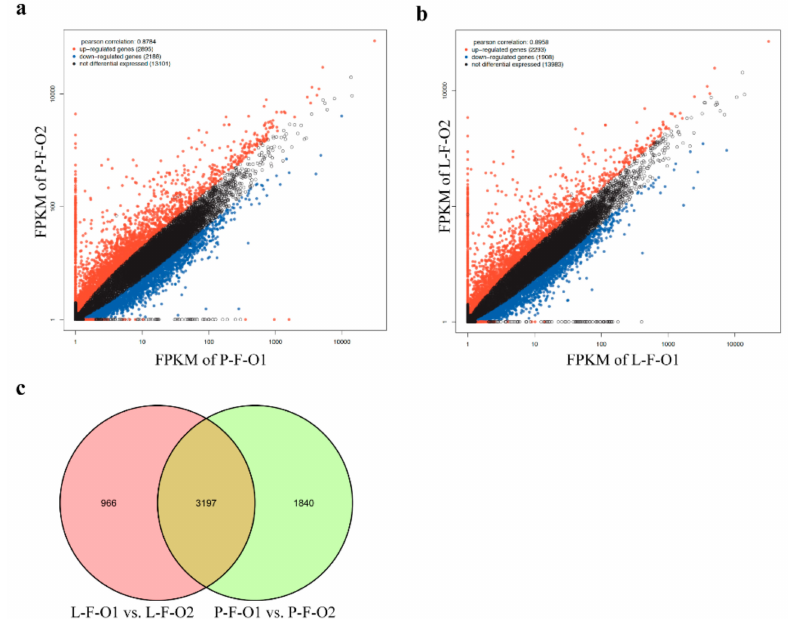
Figure 2. Two comparisons of di ff erentially expressed genes. ( a , b ) Gene expression of P-F-O1 / P-F-O2 and L-F-O1 / L-F-O2. ( c ) Di ff erentially expressed genes in comparisons of P-F-O1 vs. P-F-O2 and L-F-O1 vs. L-F-O2. P-F-O1, 32 day old early-sexual-maturity pre-laying hens; P-F-O2, 103 day